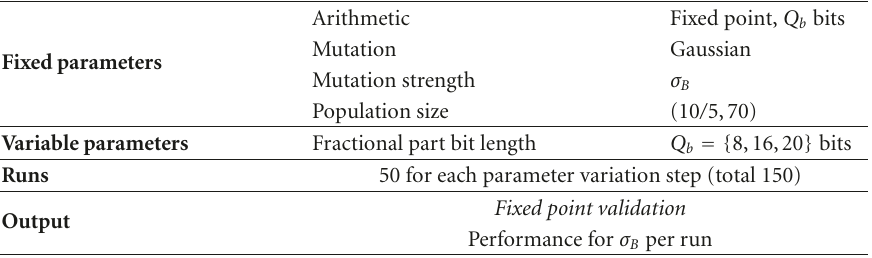
Table 5: Test no. 2. Fixed point arithmetic validation.